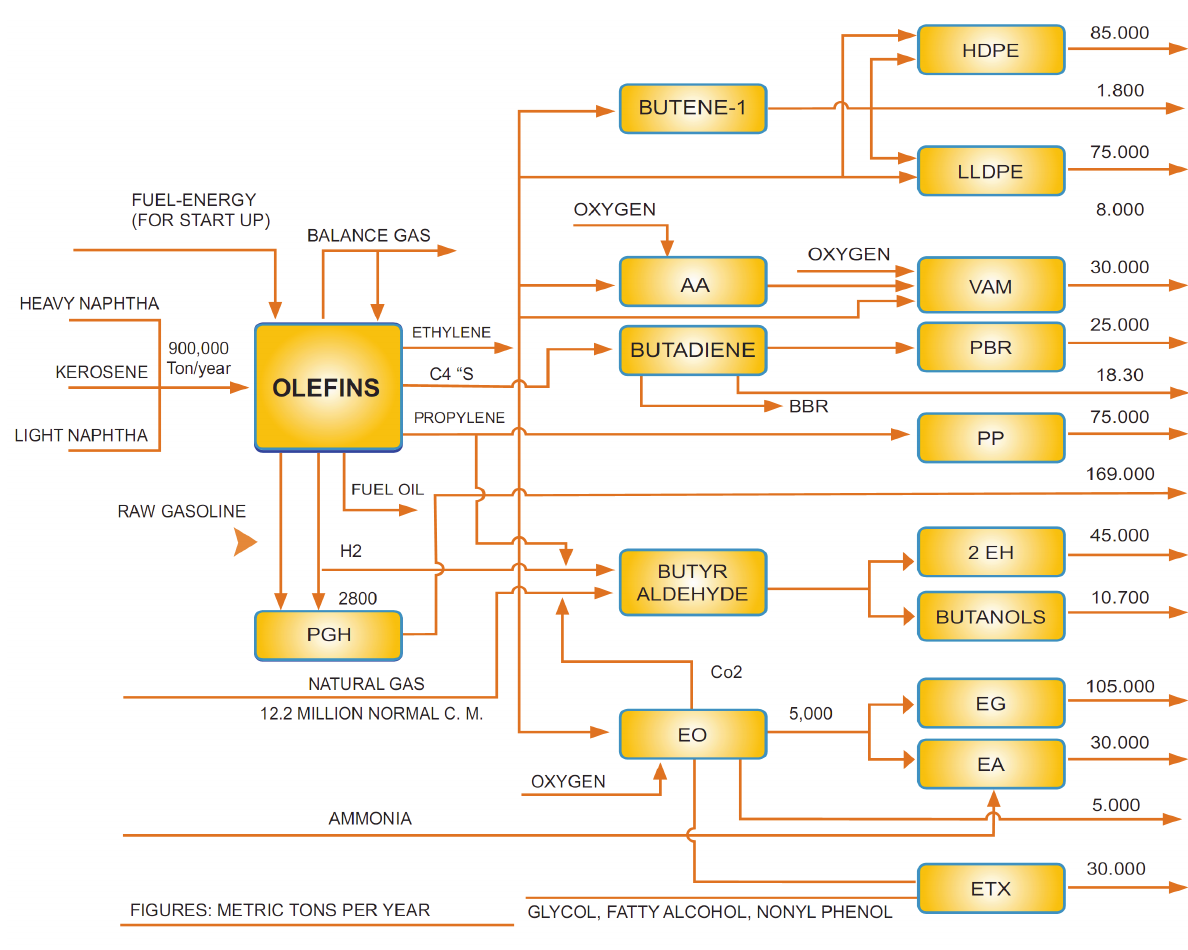
Figure 1 : Block diagram of process unit of Shazand (Arak) petrochemical